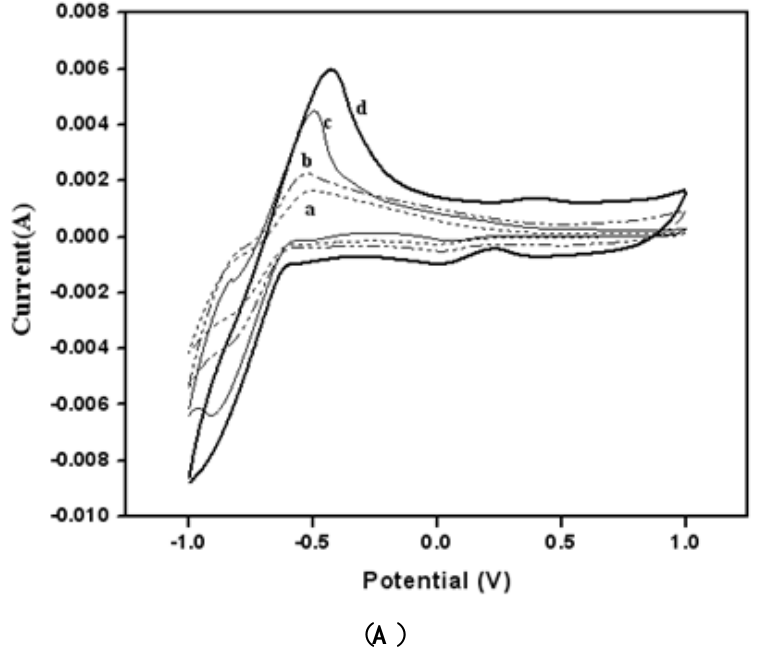
Figure 5. ( A ) Cyclic voltammograms for (a) 0.01 M PBS buffer, (b) 1 mM glucose, (c) 5 mM glucose and (d) 10 mM Glucose solution using BP 1 as working electrode; ( B ) Cyclic voltammograms for (a) 0.01 M PBS buffer, (b) 5 mM glucose, (c) 10 mM glucose, (d) 20 mM glucose using BP 2 as working electrode; ( C ) Cyclic voltammograms for (a) 0.01 M PBS buffer, (b) 20 mM glucose using BP 3 as a working